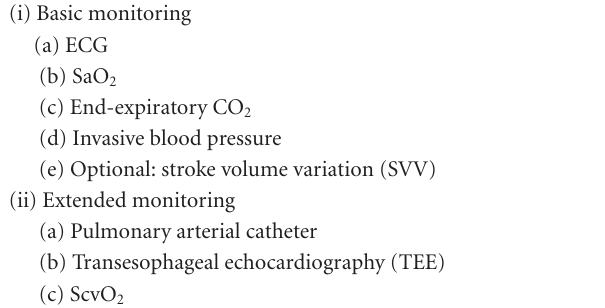
Table 8: Intraoperative monitoring: recommendation for patients with